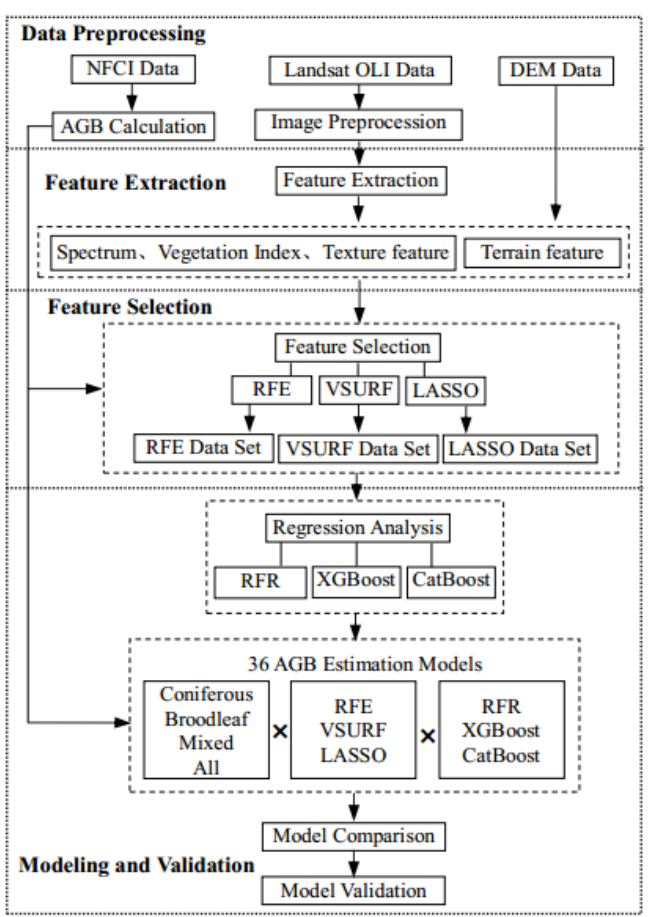
Figure 1. The methodological framework of estimating the aboveground biomass (AGB) using feature selection methods and machine learning algorithms based on the Landsat Operational Land Imager (OLI) images and the sample plot data.